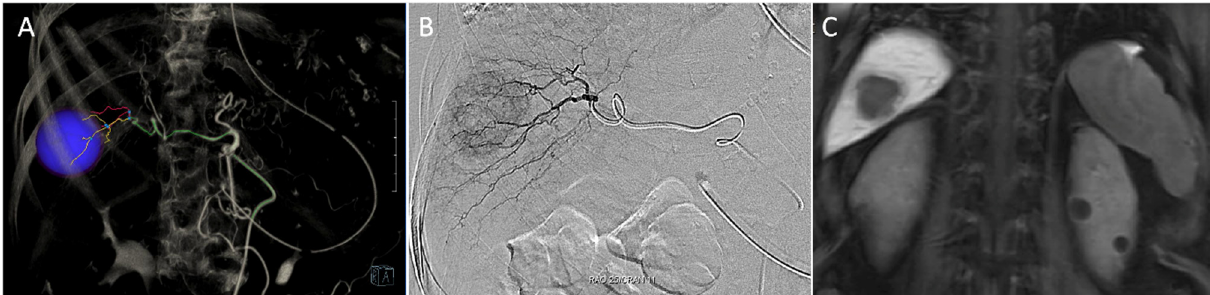
Figure 1. Preoperative angiography and magnetic resonance imaging of hepatocellular carcinoma (HCC). ( A ) Tumor localization (blue circle) and feeding artery simulation on 3D angiography CT. ( B ) A 1.9-Fr microcatheter was placed through the hepatic artery to engrave the segment containing the tumor under angiography. ( C ) Magnetic resonance imaging showed a HCC located in segment 7 with a longest diameter of 3.1 cm.